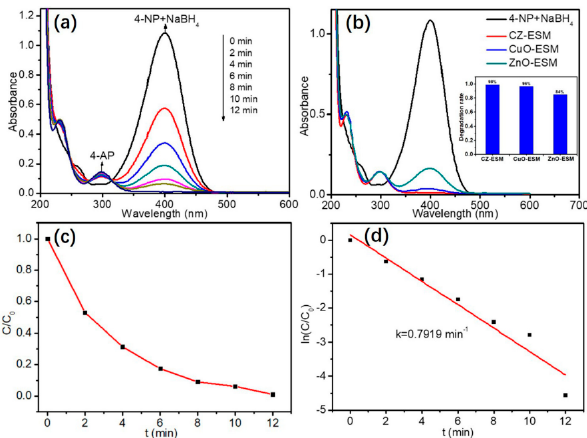
Figure 7. ( a ) Catalytic model of CZ-ESM nanocomposites for 4-NP reduction; ( b ) different samples for 4-nitrophenol at 12 min; and ( c , d ) plots of C/C 0 and ln C/C 0 versus reaction time (t) corresponding